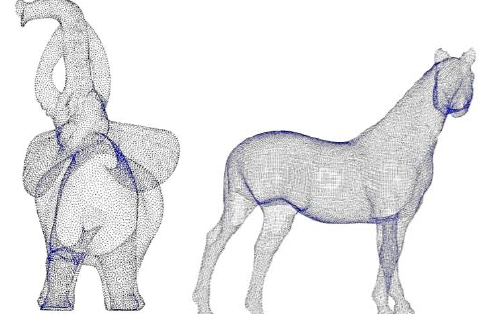
Figure 1. Point cloud in an unknown looking position either forward or backward (Luigi,